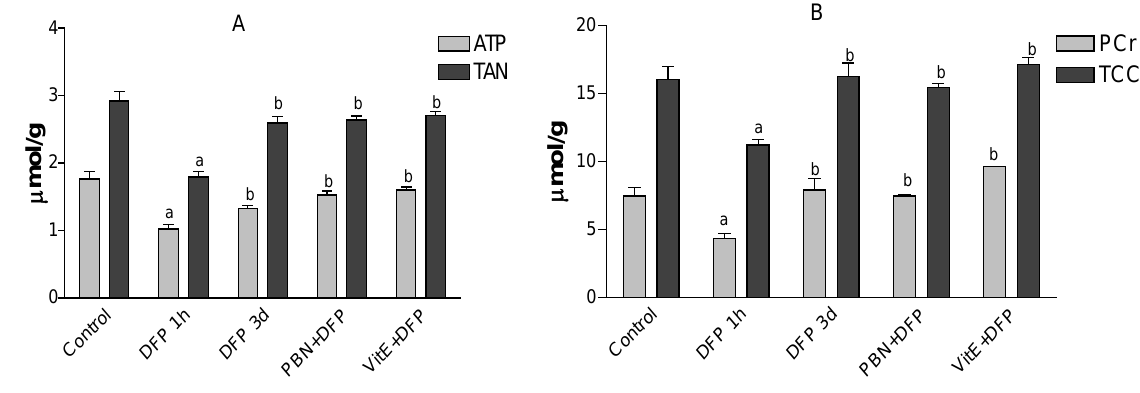
FIGURE 6. Effects of vitamin E (VitE) and N-tert-butyl- α -phenylnitrone (PBN) on DFP-induced changes on high-energy phosphates, (A) ATP and TAN and (B) PCr and TCC in hippocampus. Values are presented as mean ± SEM (n = 4–6). TAN = total adenine nucleotides (ATP+ADP+AMP); TCC = total creatine compounds. a Significant difference between control and treated groups ( p < 0.05). b Significant difference between DFP 1 h and other treated groups ( p <